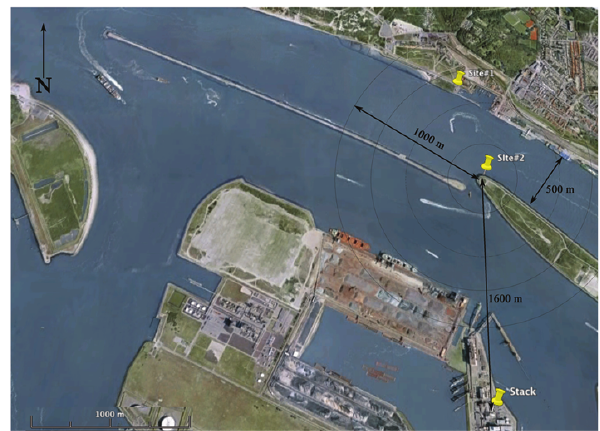
FIGURE1. MapoftheshippinglanesatHoekvanHolland.Themeasurementsitesaremarked(site#1 Fig. 1. Map of the shipping lanes at Hoek van Holland. The mea- andsite#2)andthelocationofanearbystack,usedtoverifythedistancemeasurementsisalsoindicated. Shipsmovingalongtheshippinglane(inboundandoutbound–totheWNW)weremeasuredatdistances surement sites are marked (site no. 1 and site no. 2) and the location varyingfrom100to2000m.Thescaleshownisapproximate. of a nearby stack, used to verify the distance measurements is also indicated. Ships moving along the shipping lane (inbound and out- bound – to the WNW) were measured at distances varying from 100 to 2000m. The scale shown is